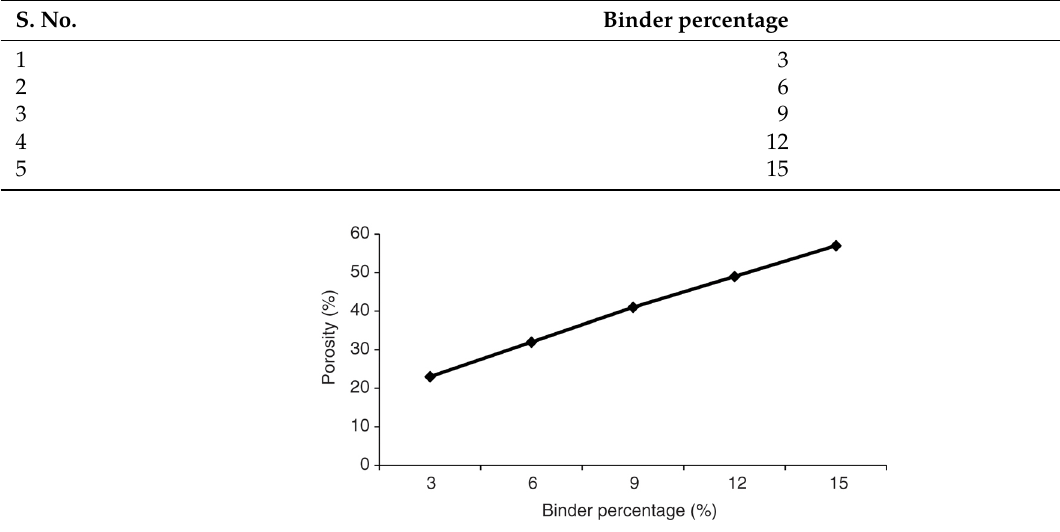
Figure 2: Porosity variation with changes in the organic binder